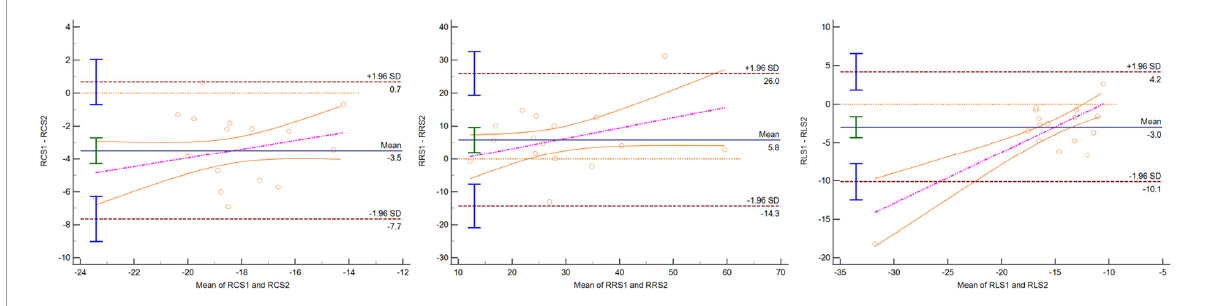
FIGURE5 Bland–Altman plot indicating that 95% or more dots were located in 95% confidence interval for mid-RCS, mid-RRS, and mid-RLS between CC and one BH CSC